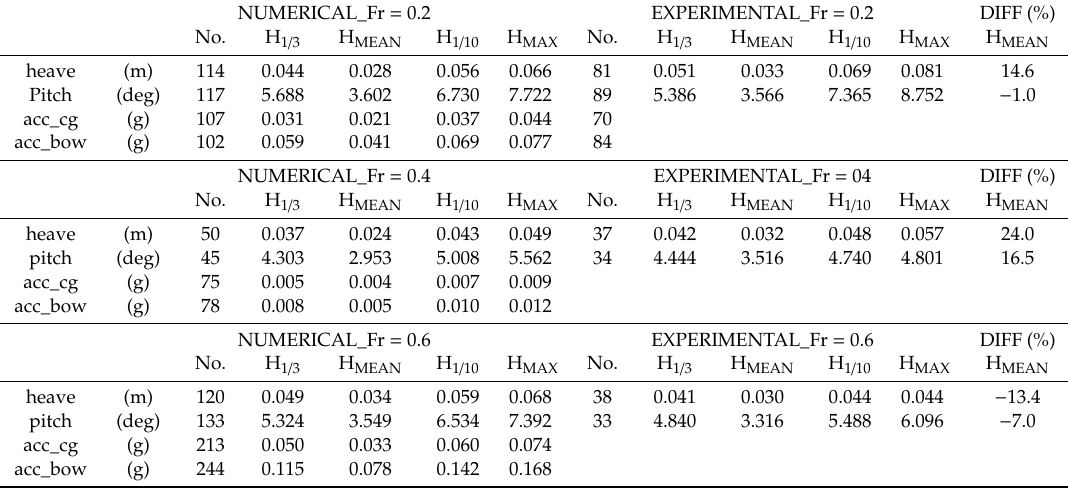
Table 7. Following seas results